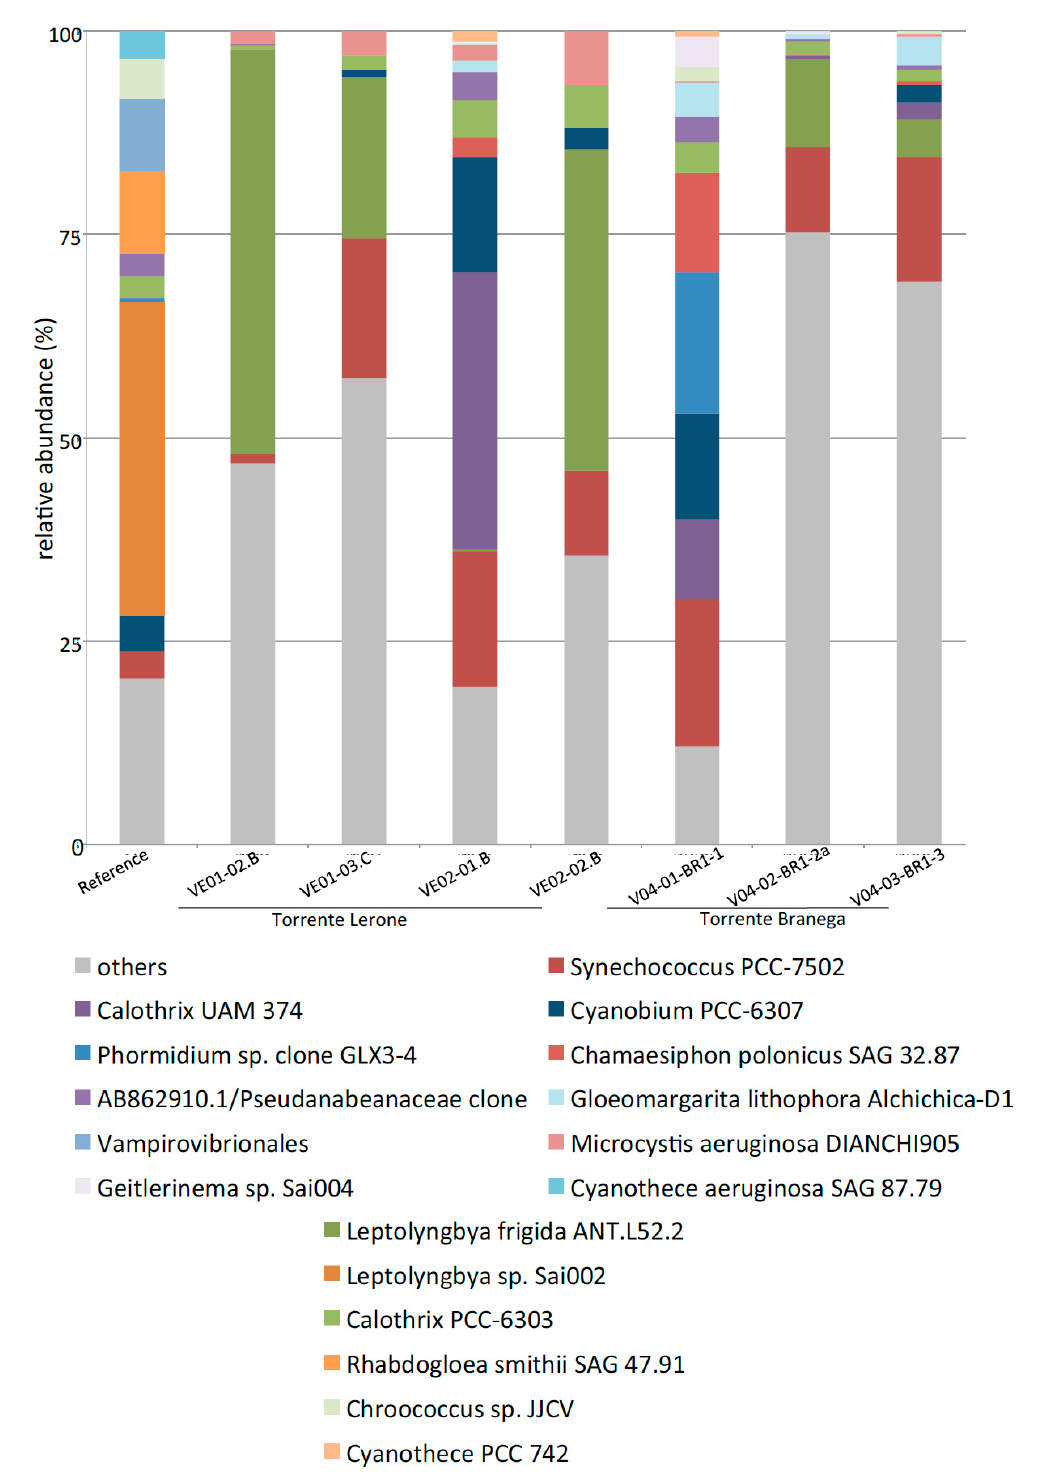
Figure 6. Bar charts showing the minor cyanobacterial groups retrieved from all sites (reference: Torrente Branega creek water sediment; VE01, VE02, Torrente Lerone spring sites; V04, Torrente Branega spring sites).